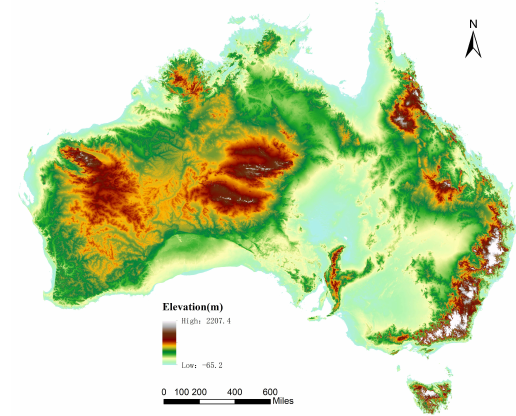
Figure 14. Elevation map of